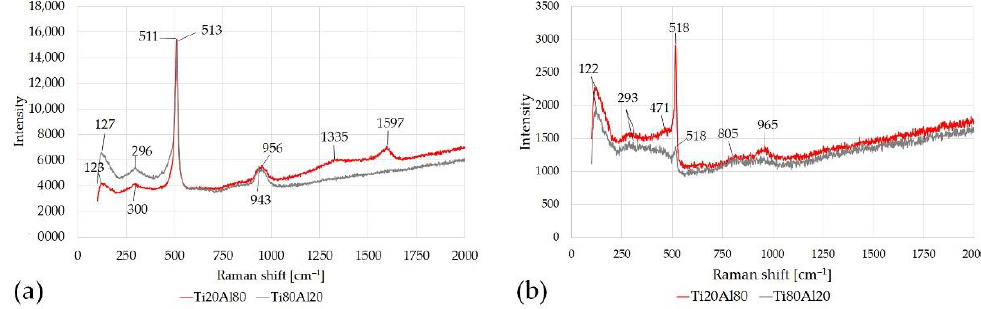
Figure 12. Raman shift for different areas in specimens Ti20–AlSi and Ti80–AlSi. ( a ) the corroded Aluminum domains, ( b ) lightly-corroded aluminum.